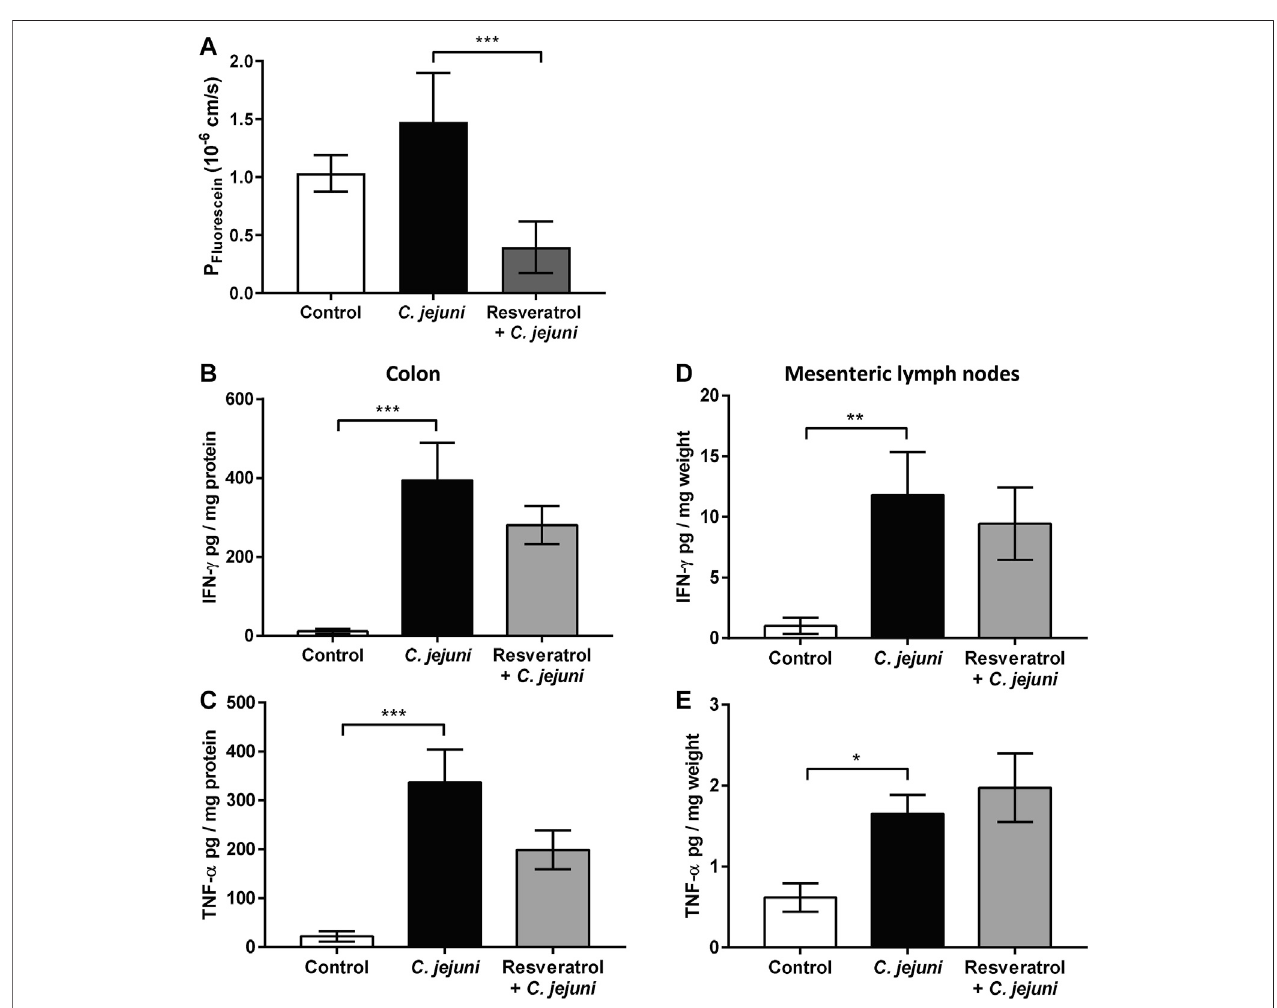
FIGURE 7 | In vivo mouse infection model and oral treatment with resveratrol. Barrier function and simulated antigen in fl ux by fl uorescein in the Campylobacter jejuni -infected mouse colon. Secondary abiotic IL-10 − / − mice were infected with C. jejuni , treated with resveratrol via the drinking water and sacri fi ced at day 6 post- infection (A) Colon specimens of C. jejuni -infected and resveratrol treated mice were mounted into Ussing chambers and fl ux measurements of fl uorescein were performed in mucosal to serosal direction (B and C) release of pro-in fl ammatory cytokines of mouse organs from colon and (D and E) mesenteric lymph nodes. Organ specimens were cultured in cell culture medium and supernatant was analyzed by Cytometric Bead Array for (B and D) IFN- γ and (C and E) TNF- α concentrations ( n (cid:2) 4 – 17, * p < 0.05, ** p < 0.01, *** p < 0.001, Mann Whitney U -test).